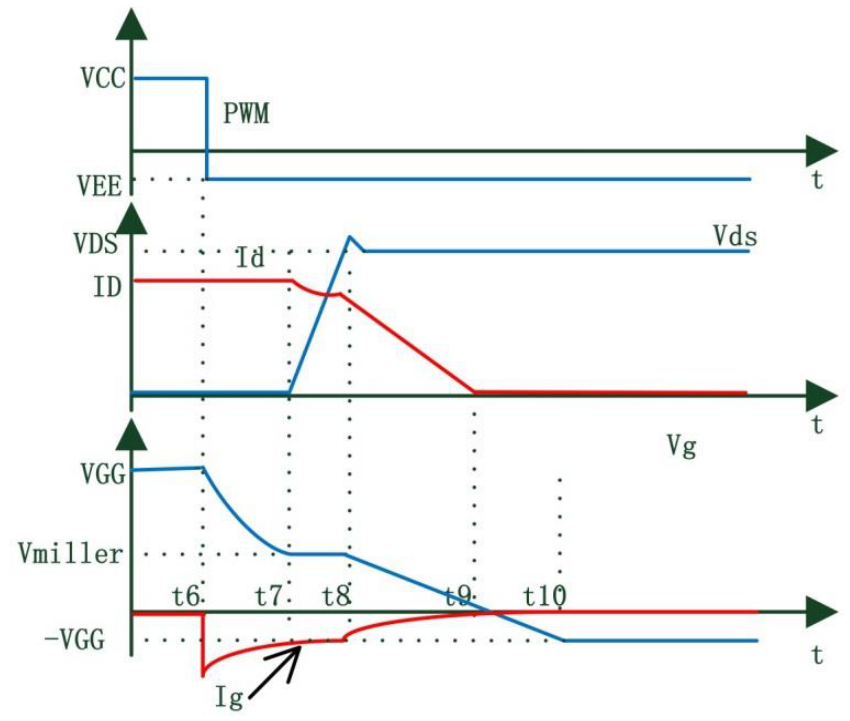
Figure 4. Turn-on voltage and current of SiC MOSFET under hard switching conditions.